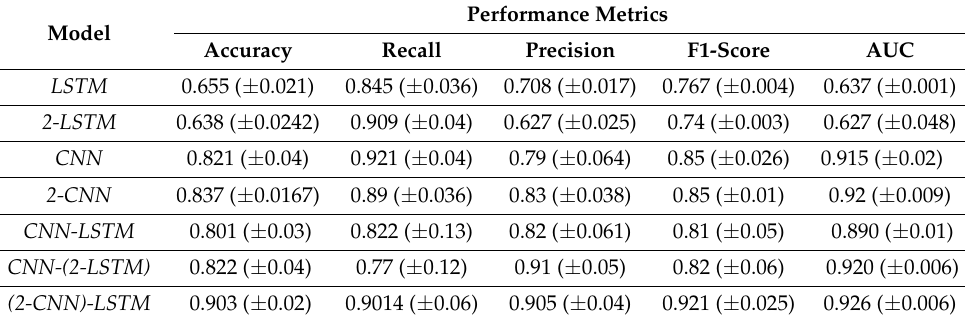
Table 2. Performance metrics of the tested models (using one sensors’ readings).